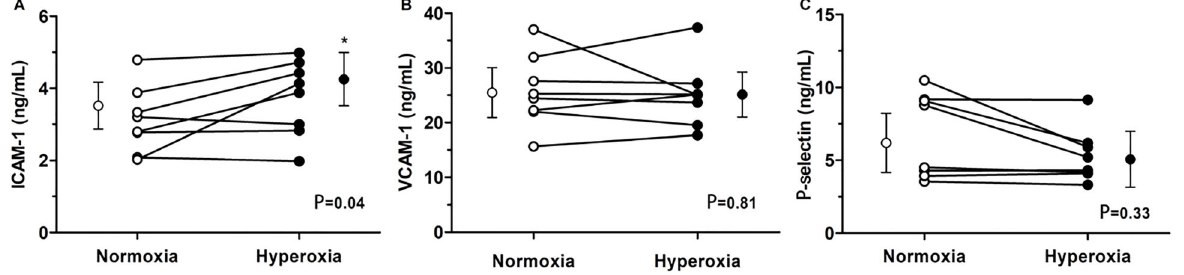
Figure 1. Venous plasma levels of ICAM-1 ( A ), VCAM-1 ( B ), and P-selectin ( C ) in healthy men (n=8) at normoxia (21% O 2 ) and during hyperoxia (100%